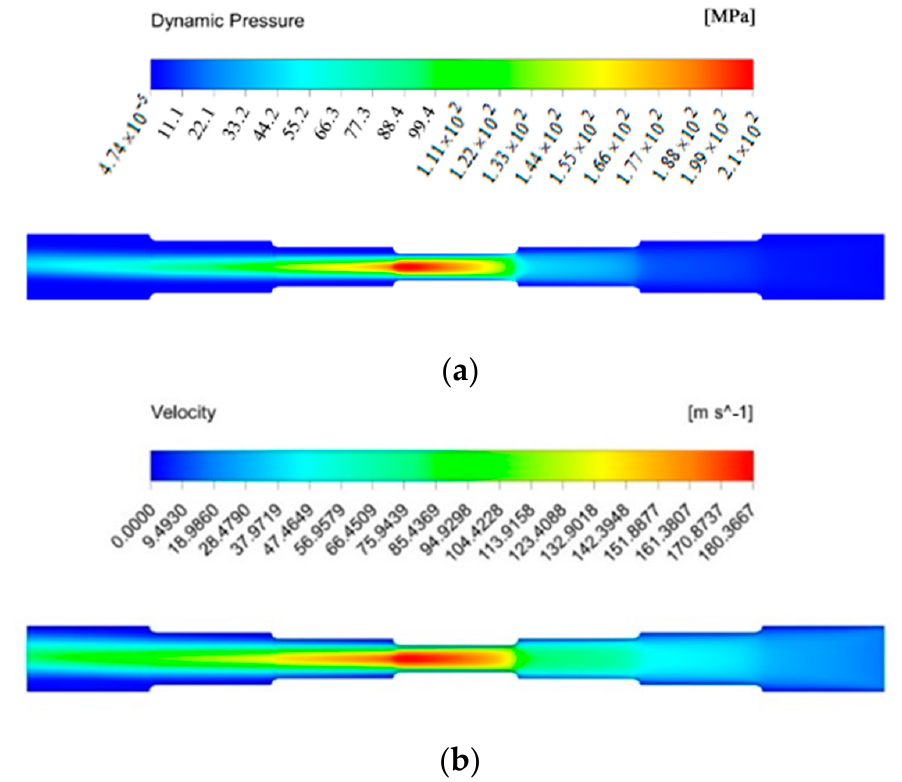
Figure 9. The flow state diagram at 50 m/s, 45 V, and 500 μ m. ( a ) dynamic pressure cloud diagram; ( b ) velocity cloud diagram.